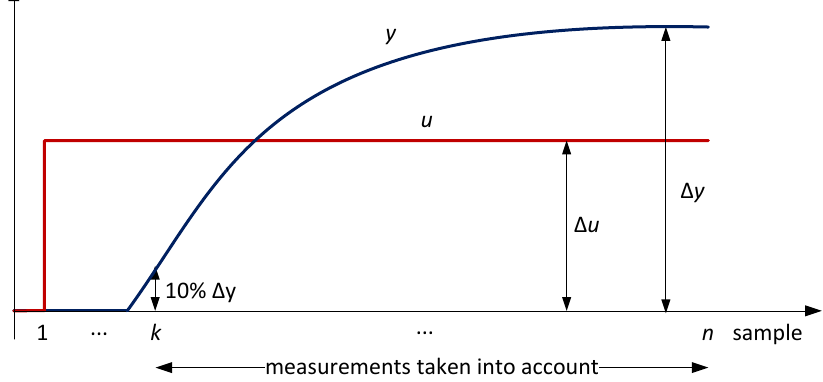
Figure 5. Time range of measurements considered in the regression method.